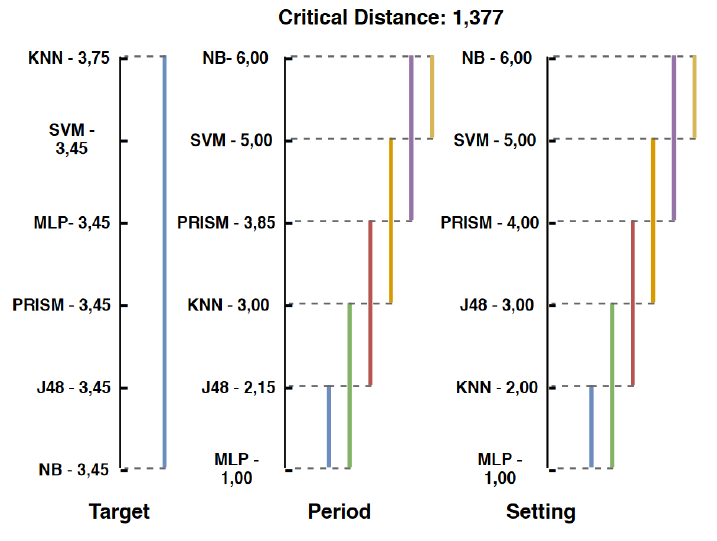
Figure 9. Friedman test.